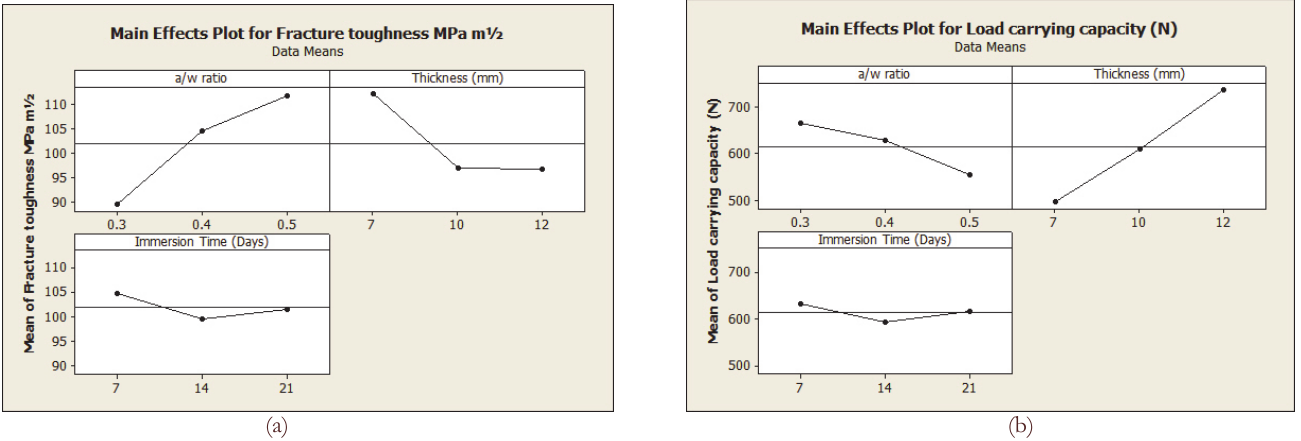
Figure 4: Main effect plot of (a) Load carrying capacity (b) Fracture toughness MPa m½.